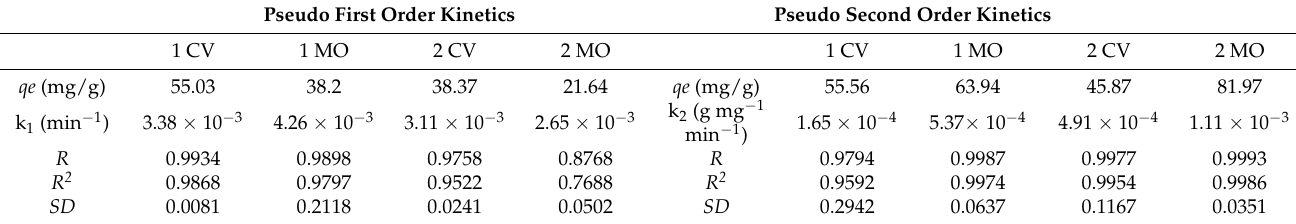
Figure 12. The rate adsorption of nanocomposites (1) and (2) for the CV and MO dyes fitted by pseudo-second-order rate equation. (100 mg/L dye, adsorbent 0.05 g, and 50 mL of total volume solution was used in this experiment). Table 3. Parameter values and correlation coefficients for pseudo-first-order and pseudo-second order kinetics models for adsorption of CV and MO dyes by (1) or